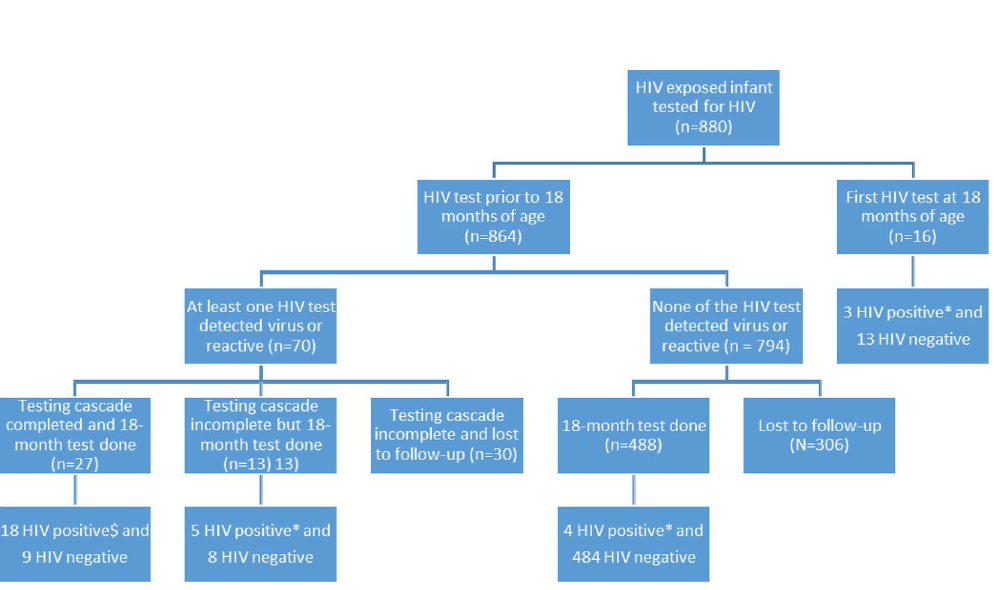
Figure 4. Flow-chart of retention in EID testing cascade among HIV exposed infants with at least one HIV test (n = 880). $ HIV diagnosis confirmed by detection of HIV-1 in two DNA PCR samples. *HIV diagnosis confirmed by 18-month antibody